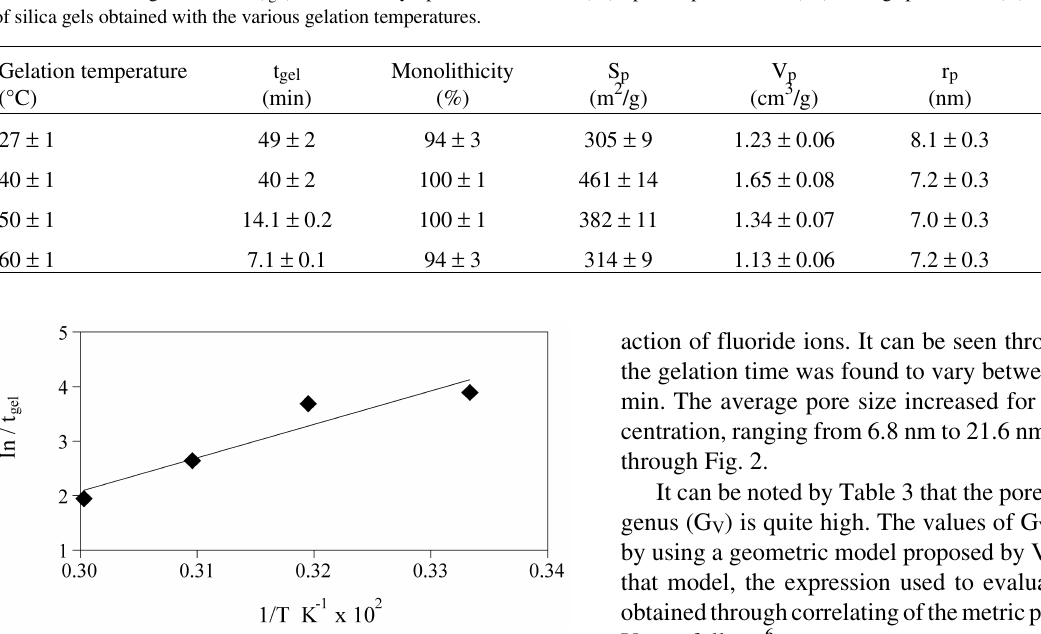
Figure 3. Gelation time as a function of gelation temperature.